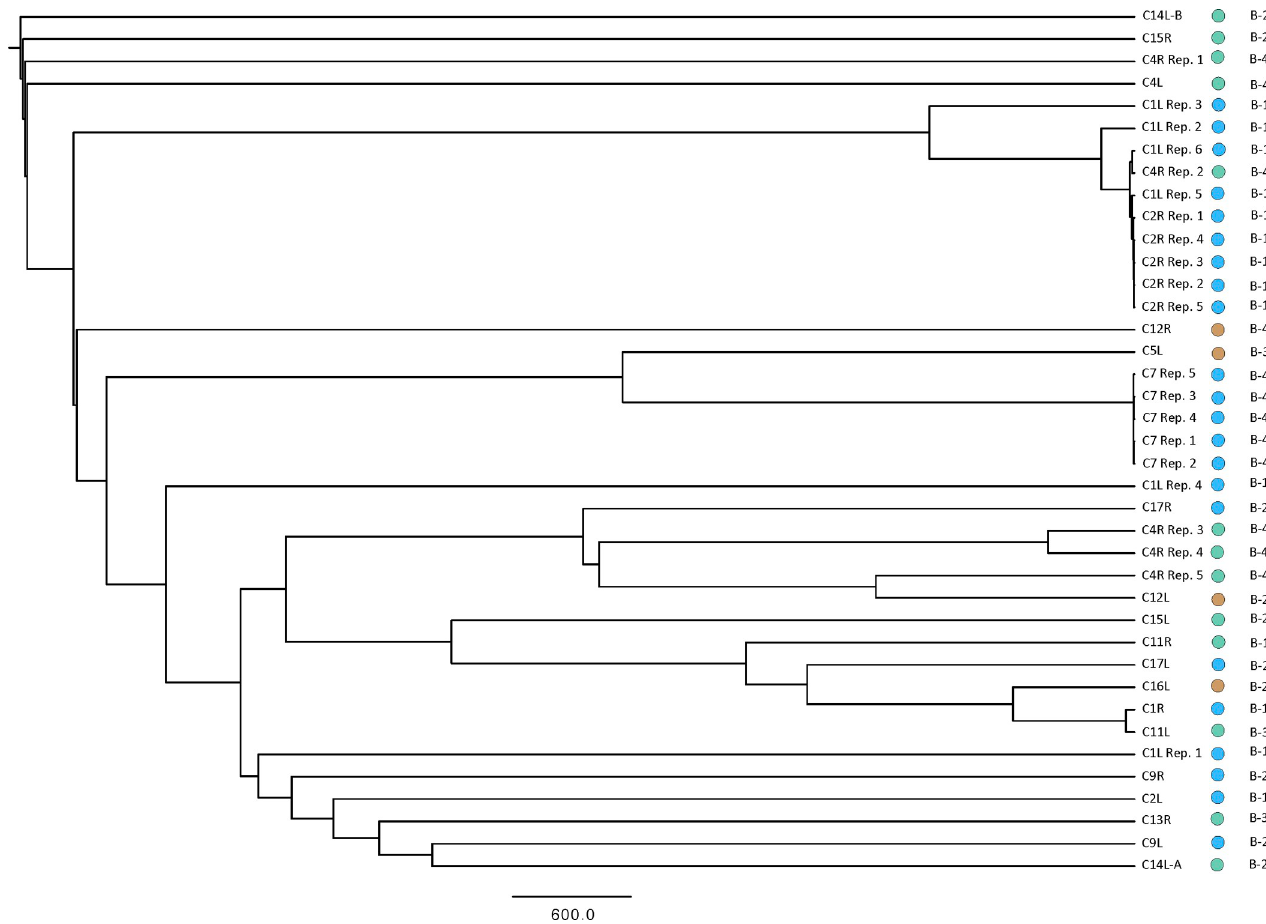
Fig 4. Hierarchical clustering analysis. Hierarchical relationship among samples based on Euclidean distance of 16S- OTU abundances. The UPGMA clustering algorithm was used to obtain the hierarchical relationships between samples. Node labels indicate the sample ID. Note sample C8R and C14R were excluded from rarefaction analysis as the samples had half the number of total sequence reads compared to other samples. Circle color: Green = Smooth Round Gel; Blue = Textured Gel (round or anatomical); Brown = Smooth Round Saline. B stands for Baker.